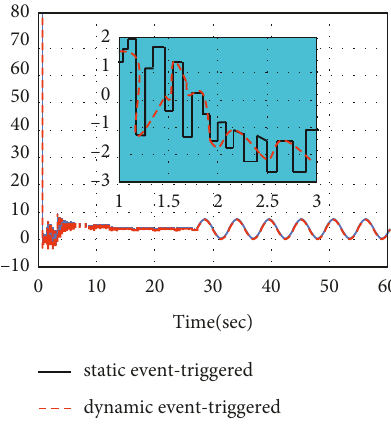
Figure 10: Control input of system.